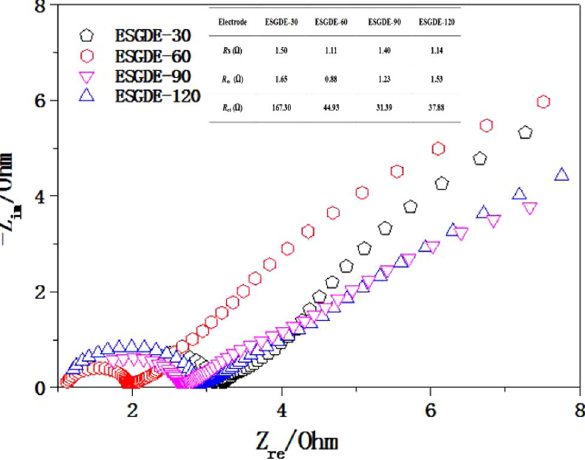
Figure 6. Nyquist plots of the ESGDEs in 0.5 M CO 2 -saturated KHCO 3 solution (pH = 7.47). Inset figure: simulated data of equivalent circuits for the Nyquist plots of impedance. R s : solution resistance, R Ω : Ohm resistance, R ct : charge transfer resistance.